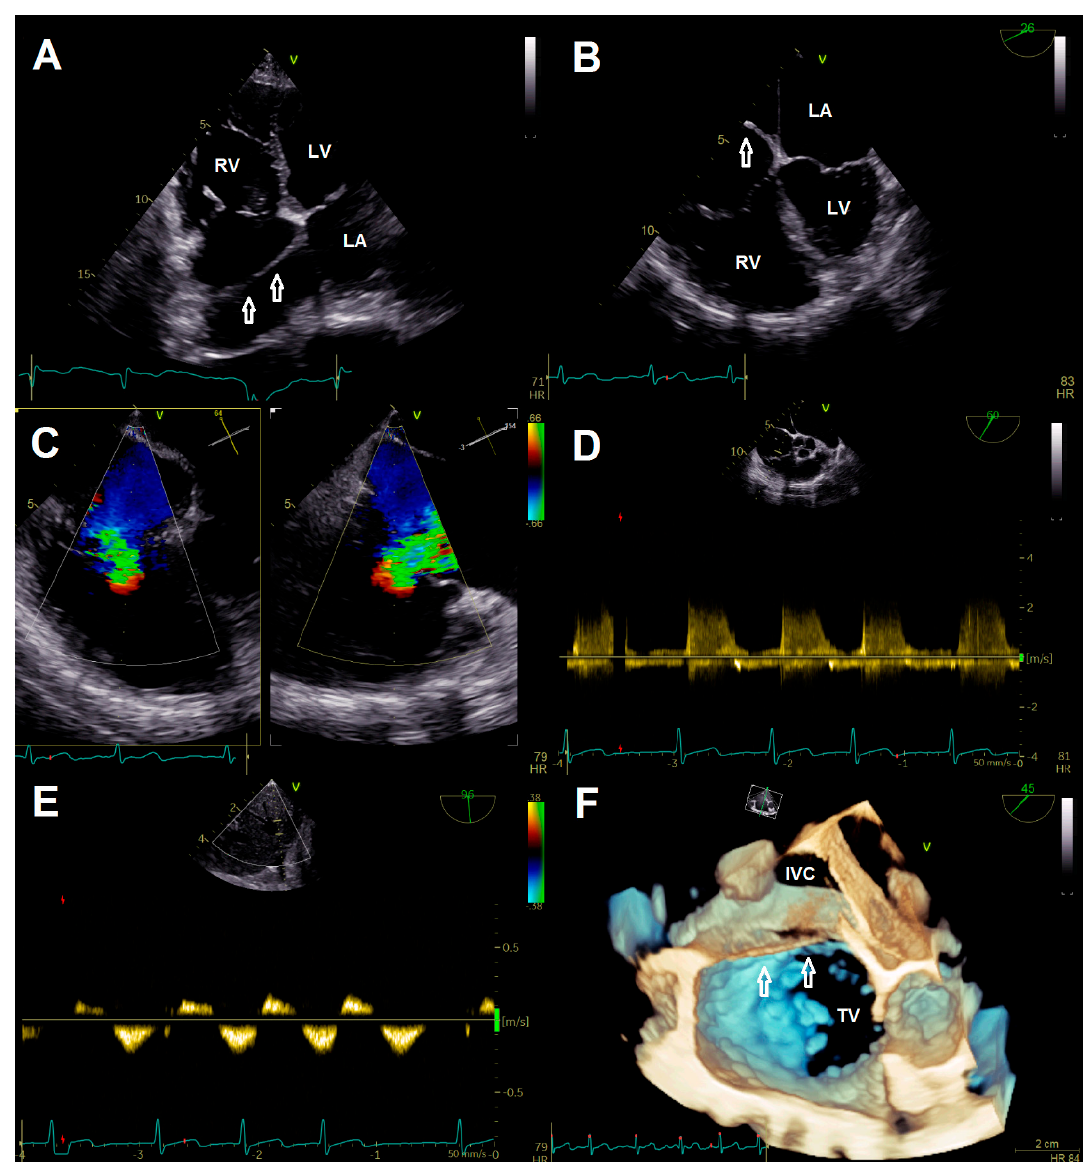
Figure 1. ( A ) Transthoracic four chamber view displaying the additional membrane in the right atrium (arrows). ( B ) Transesophageal four-chamber view demonstrating the membrane (arrow) resulting in a cor triatriatum. ( C ) Multiplane color doppler image revealing massive tricuspid regurgitation. ( D ) Continuous wave doppler showing no significant tricuspid gradient excluding tricuspid stenosis. ( E ) Flow reversal in liver veins; ( F ) 3-D image for visualization of access route. Abbreviations: IVC, inferior vena cava; LA, left atrium; LV, left ventricle; RV, right ventricle; TV, tricuspid valve.